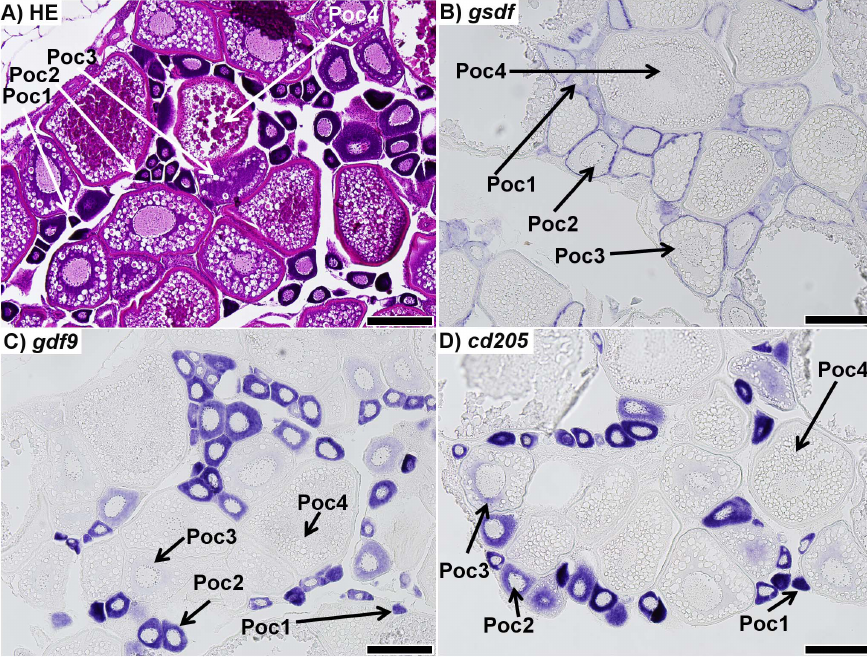
Figure 1. Sections of ovaries from 7 month-old zebrafish. A) Representative haematoxylin-eosin (HE) staining of the mature zebrafish ovary. B) in situ hybridization (ISH) of gsdf transcripts in the ovary; staining shows gsdf transcripts are localized in somatic cells surrounding primary oocytes. The staining is strongest in stage 2 primary oocytes (Poc2) and previtellogenic oocytes (Poc3). C) ISH of gdf9 transcripts in the ovary; strong signal is detected in stage 1 and 2 primary oocytes (Poc1 and Poc2). Weak signal is detected in previtellogenic oocytes (Poc3), while no signal was detected in vitellogenic oocytes (Poc4). D) ISH of cd205 transcripts in the ovary; strong signal is detected in stage 1 and 2 primary oocytes, with weak signal in previtellogenic oocytes, and no transcript detected in vitellogenic oocytes. All scalebars represent 200 m